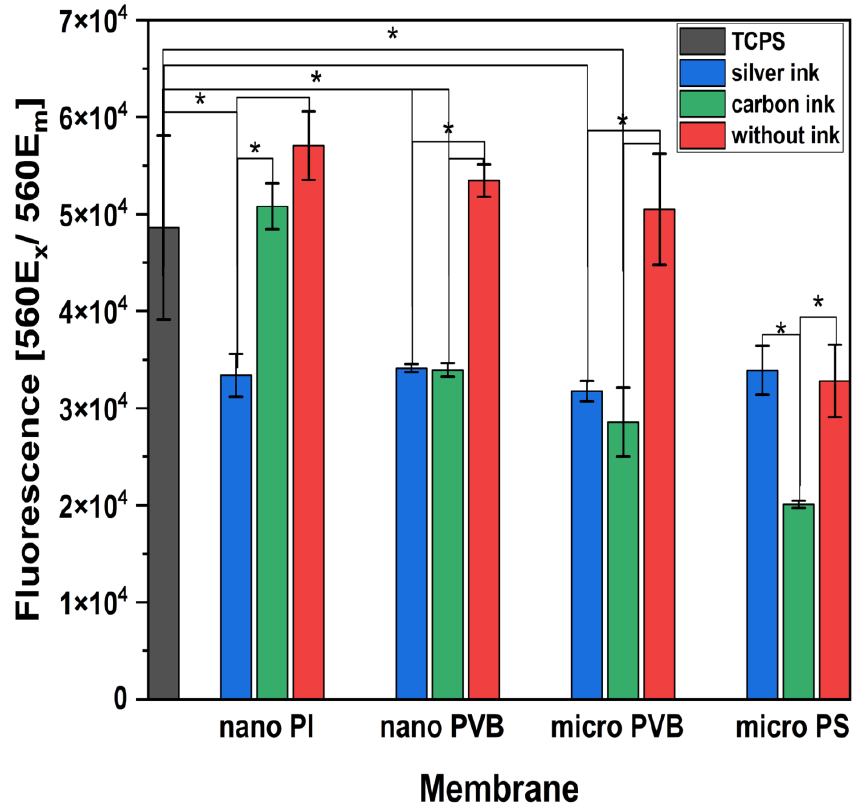
Figure 8. Cytotoxicity test after 24 h of cell culture with the medium incubated for 72 h with PI and PVB nanofibers, PVB and PS microfibers pristine and printed with silver and carbon ink; TCPS was used as a positive control. * Statistical significance calculated with ANOVA, followed by Tukey’s posthoc test, p < 0.05; error bars are based on standard deviation. All the micro PS samples showed statistically significant differences with TCPS.